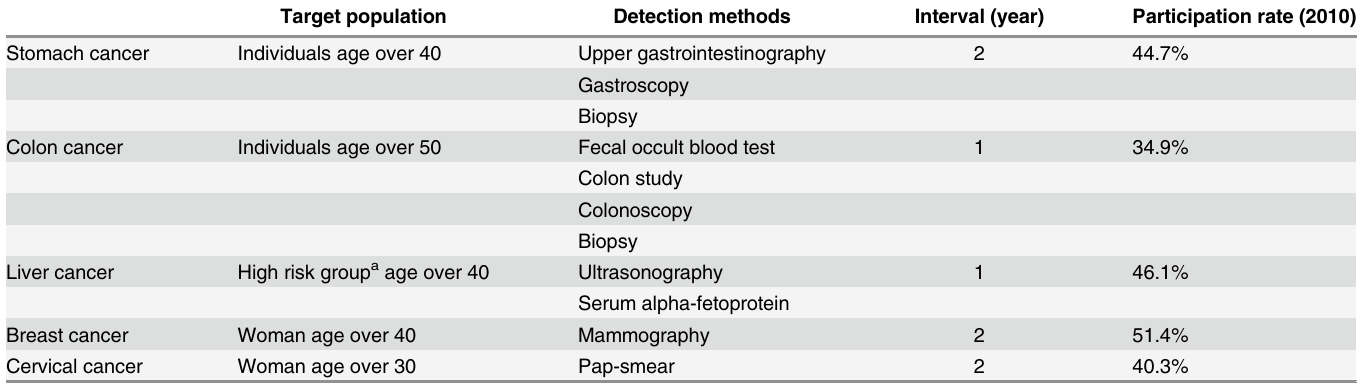
Table 1. National Cancer Screening Program of South